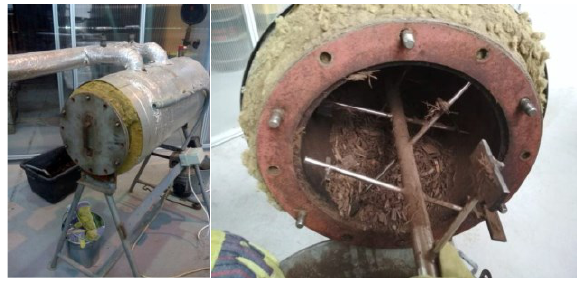
Fig. 2. Experimental indirect dryer